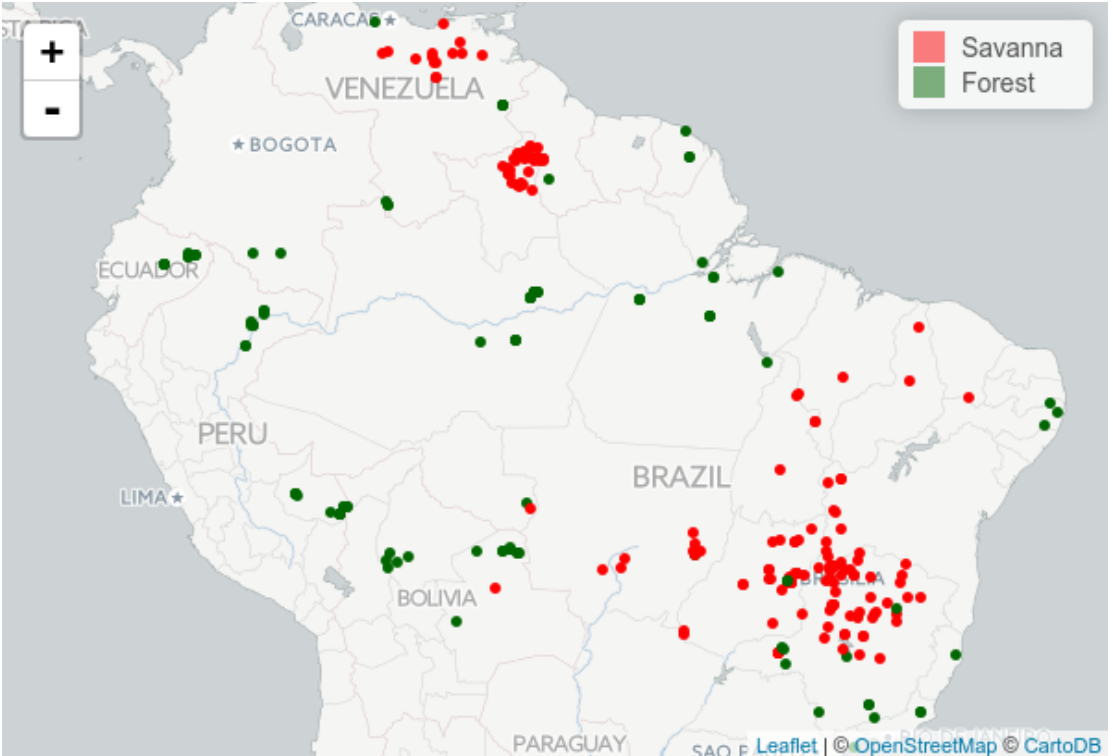
Figure 5. Geographical distribution of the areas considered in Tropical South America, corresponding to the data collected for training and validation. Imported form [38].